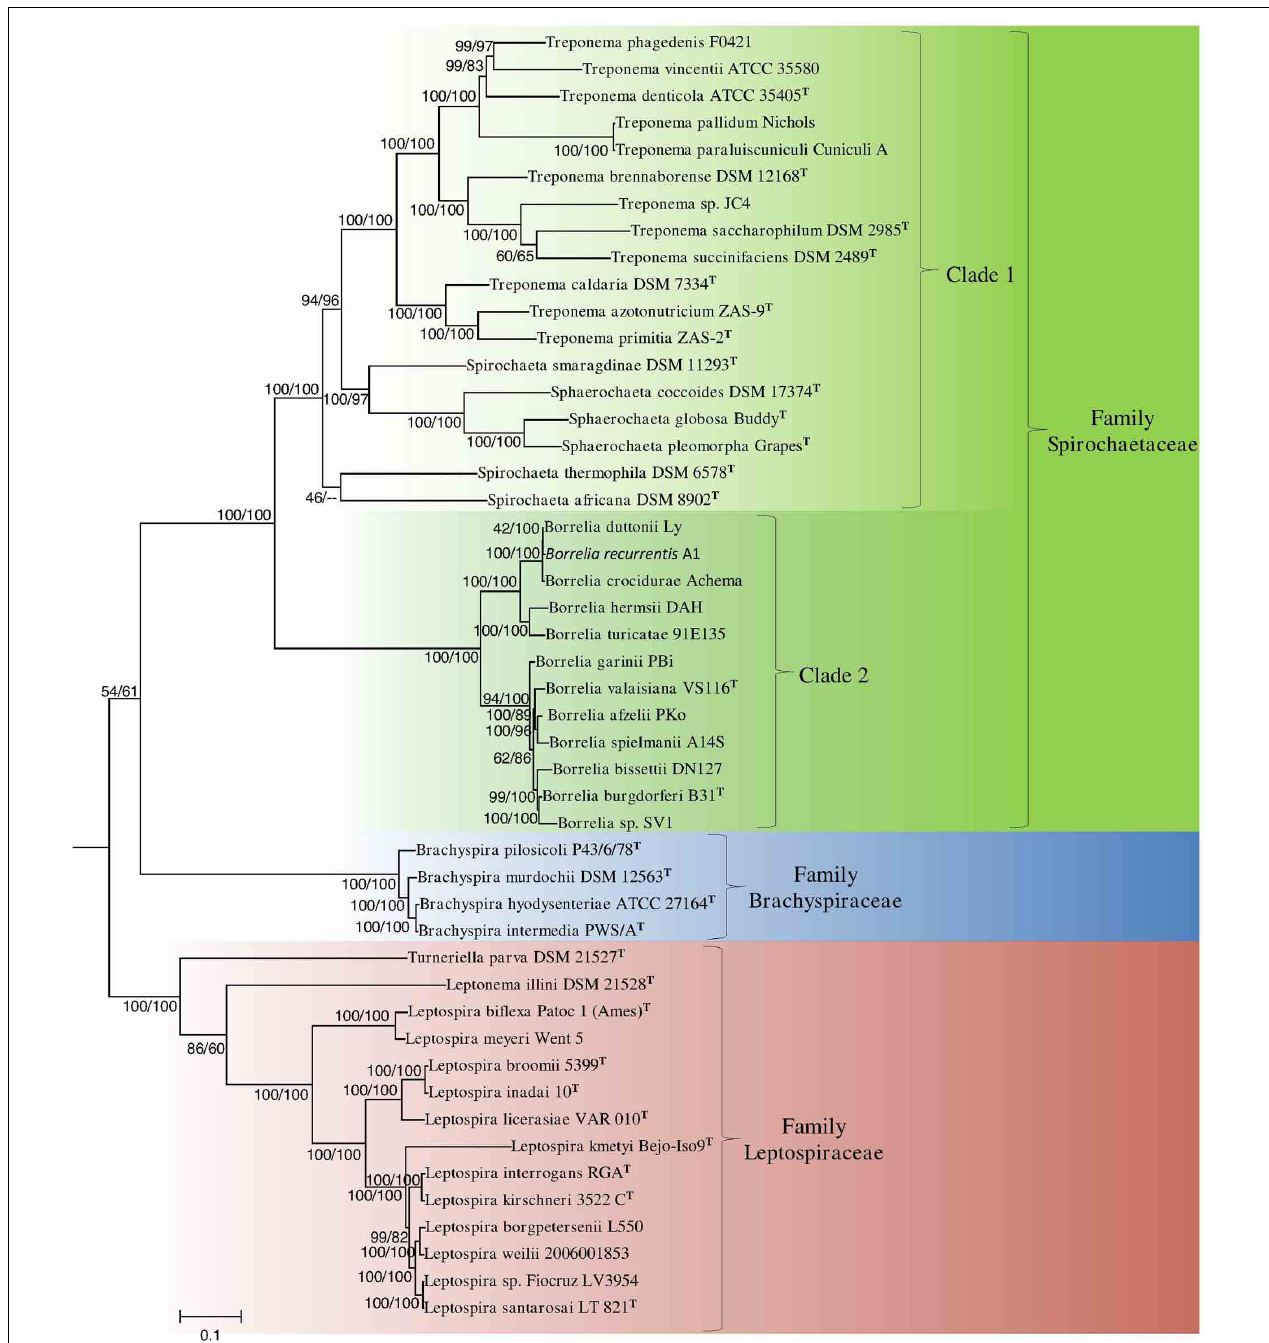
FIGURE 1 | A phylogenetic tree of genome sequenced members of the phylum Spirochaetes based on the concatenated amino acid sequences of 22 conserved proteins. The tree shown is a maximum-likelihood (ML) distance tree. Bootstrap values are shown at branch nodes for both phylogenetic trees (Gupta, 1998; Gupta and Griffiths, 2002;